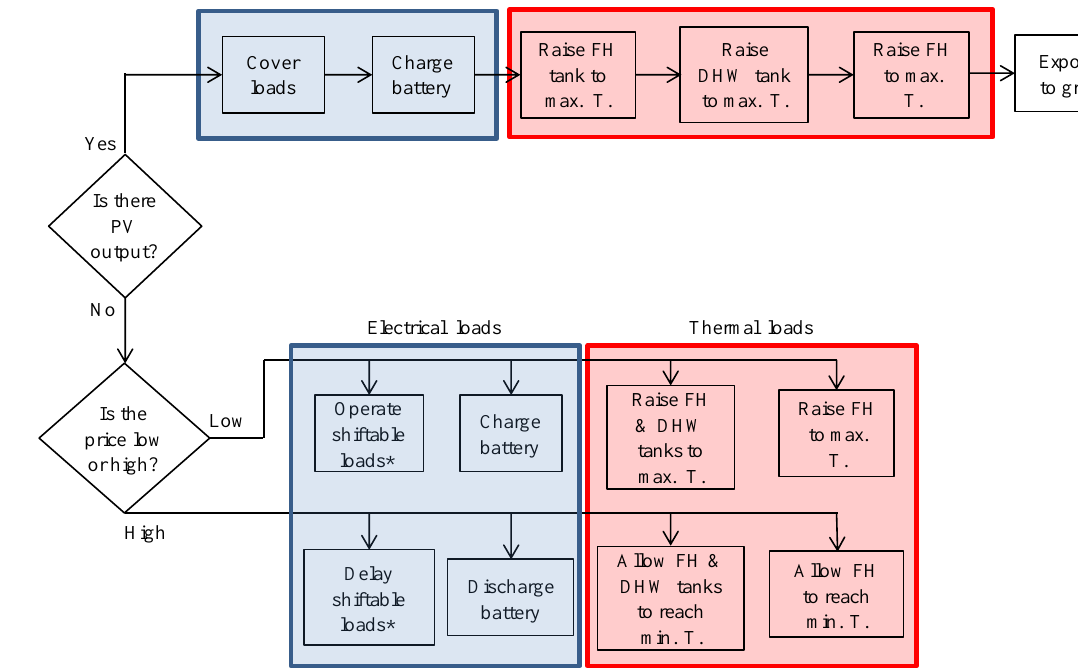
Figure 2. The utilization of the photovoltaic (PV) output surplus, and the price-based energy management actions, as implemented through the rule-based control (RBC). *For future prices (FP) and past and future prices (PFP), the shiftable machine loads are shifted to the lowest cost hour within their window of operation.